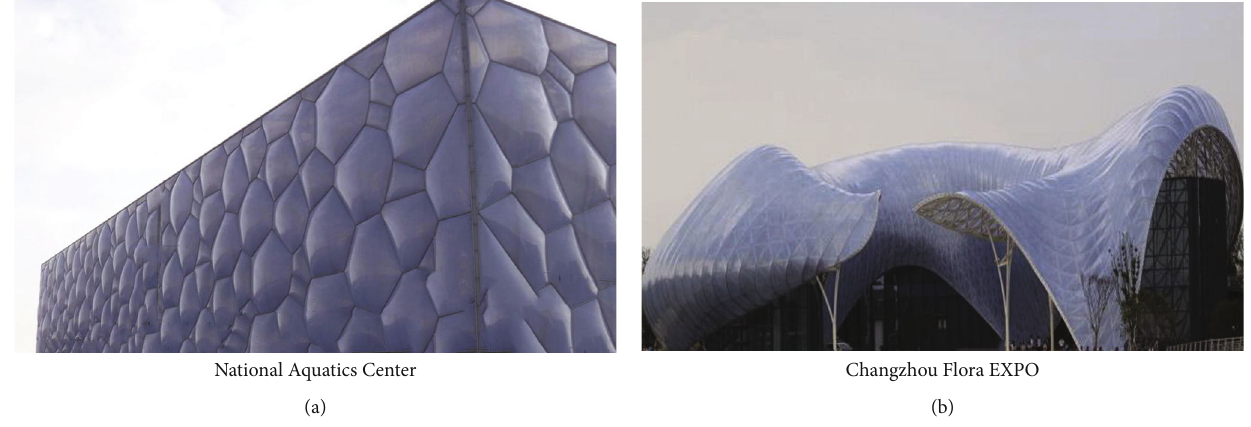
Figure 5: Typical ETFE structures. (a) National Aquatics Center. (b) Changzhou Flora Expo